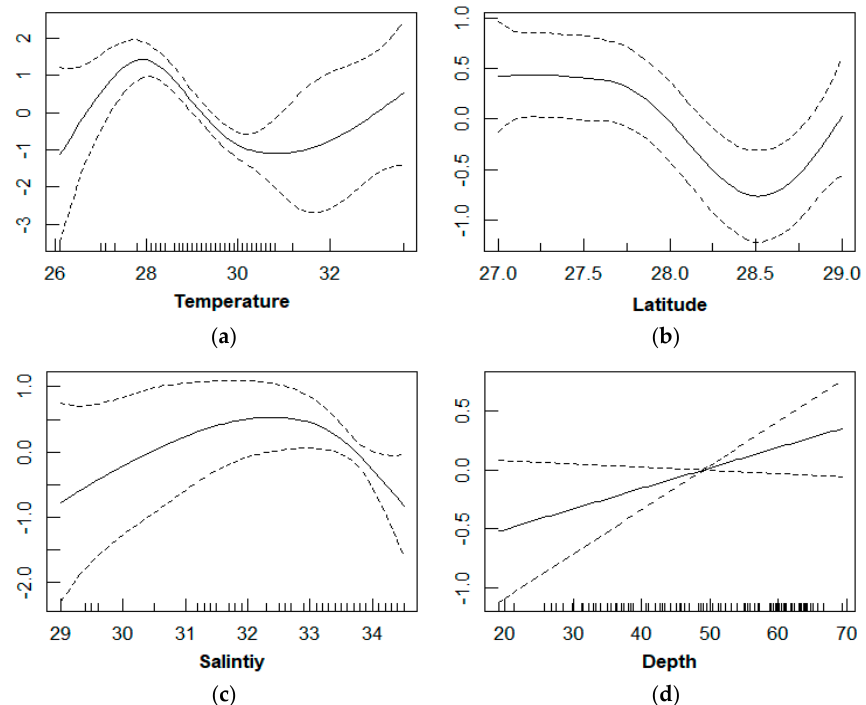
Figure 2. Relationship between the density of D. maruadsi and environmental factors in coastal wa- ters of southern Zhejiang at seasonal scales (Spring): ( a ) effect of temperature; ( b ) effect of salinity and ( c ) effect of depth. Dashed lines show 95% confidence intervals.